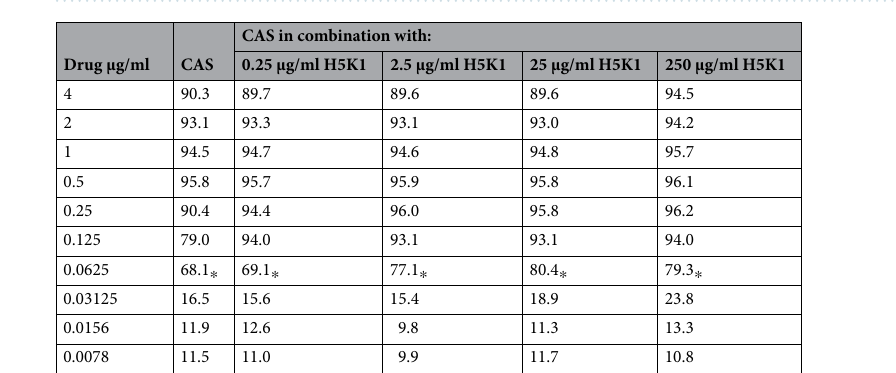
Table 2. Percentage of growth inhibition at 24 h of CAS and CAS in combination with H5K1. The MIC50 breakpoints are marked with *.